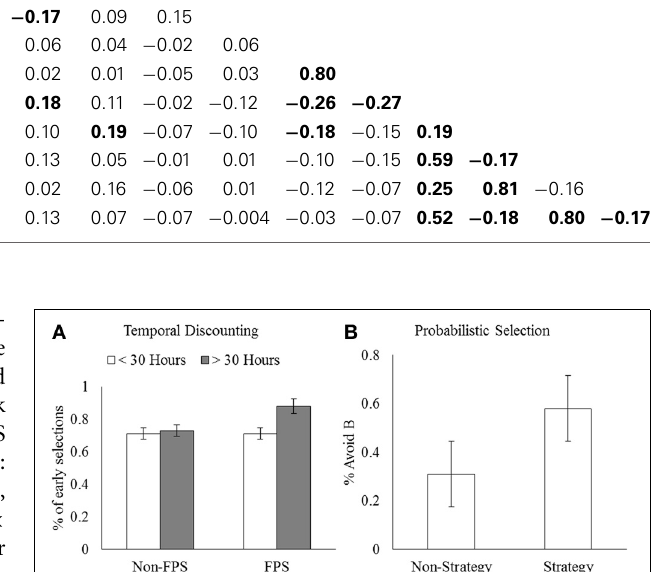
Selection from bad decks in the IGT was positively corre- lated with Hours × PVP ( Figure 2A ), supporting the idea that increased hours and pathology are related to reduced learning from negative outcomes. The percentage of low risk selections in the risk task was negatively correlated with Hours, Hours × PVP, and Hours × FPS, indicating greater risk taking among gamers. Importantly, the total score in the risk task was neg- atively correlated with Hours and Hours × PVP ( Figure 2B ),